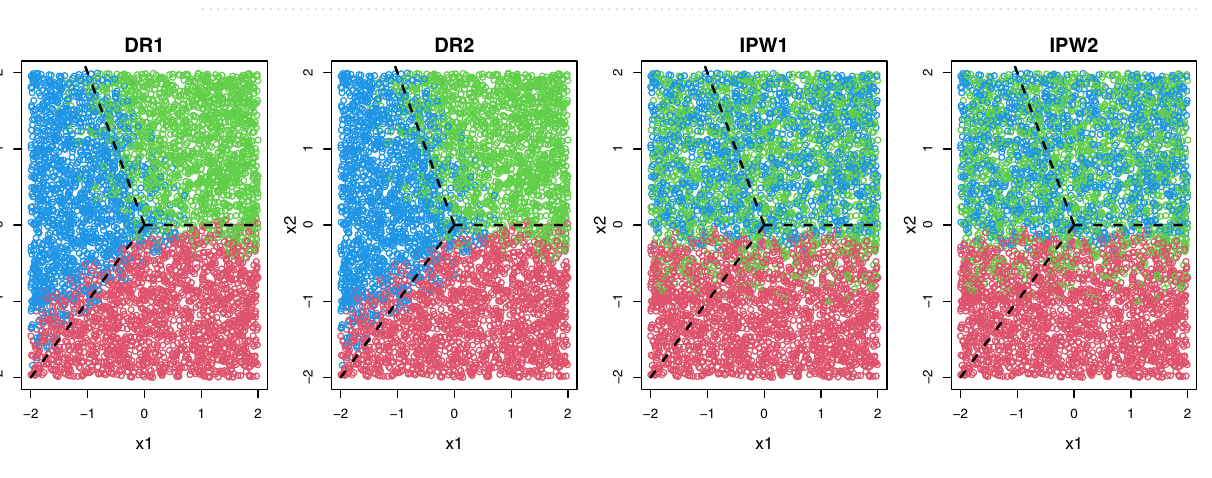
Figure 3. Treatment allocations of DR and IPW estimators when there are three treatment options, where the lower bound of contrast function (12) is applied to DR1 and IPW1 while the upper bound (13) is used in DR2 and IPW2,